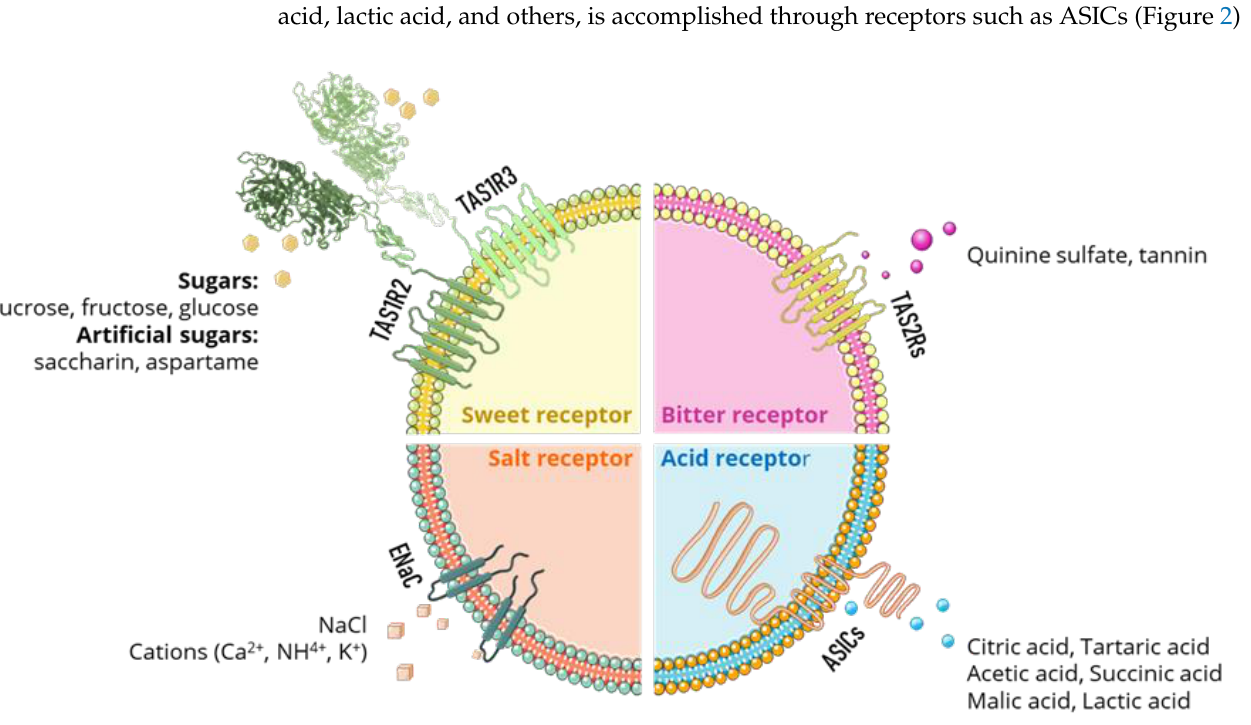
Figure 2. Examples of natural stimuli and taste receptors are involved in the recognition of four taste modalities — sweet, salty, sour, and bitter.